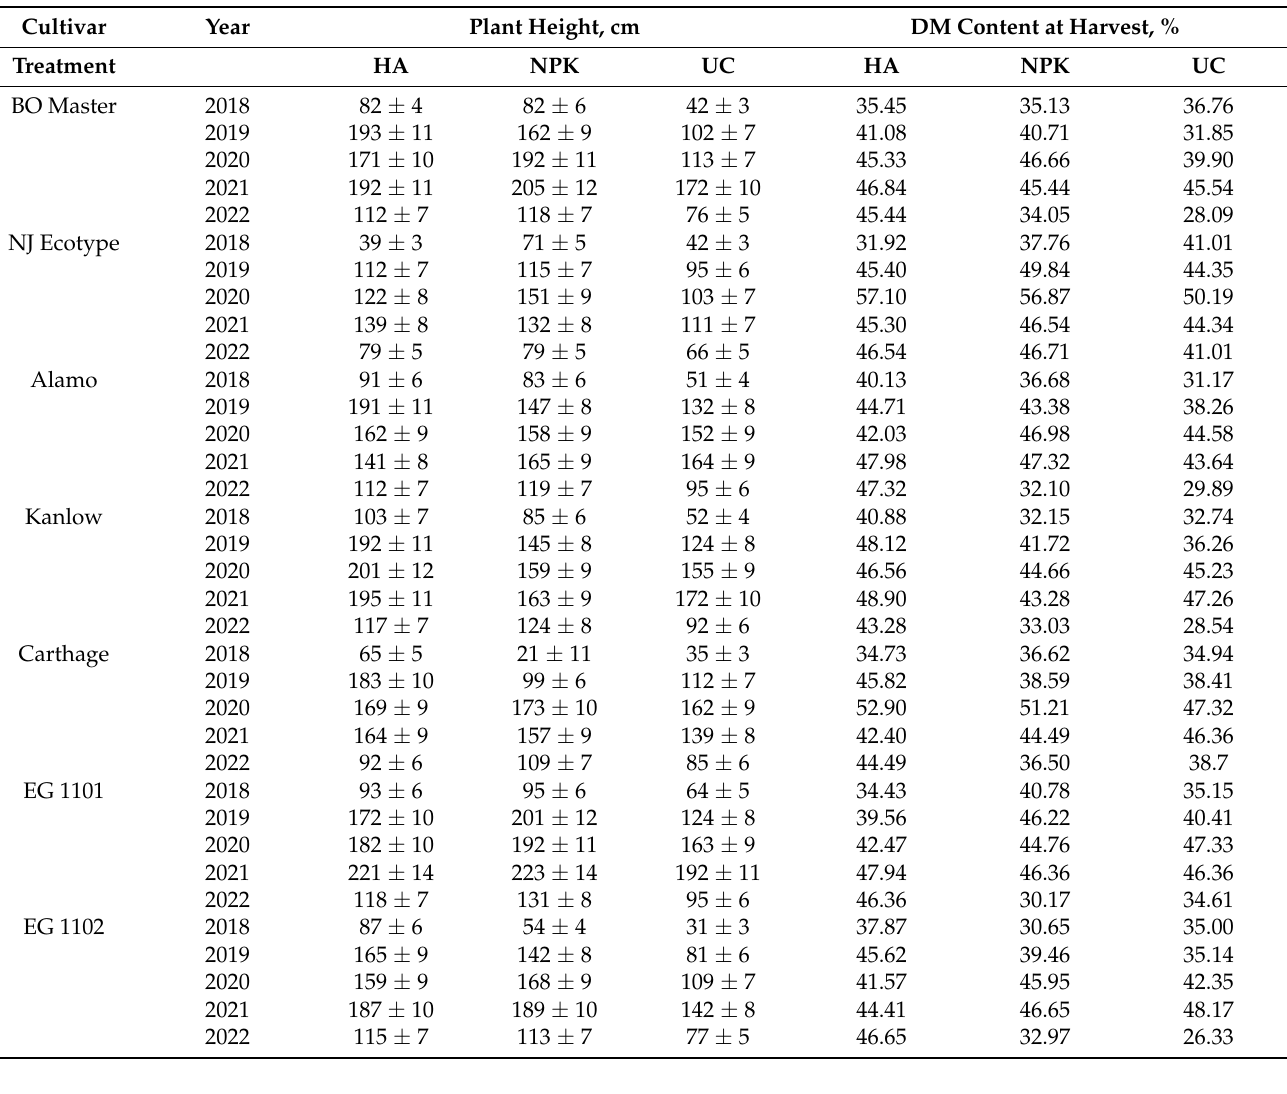
Table 7. Plant height and dry matter content at harvest.